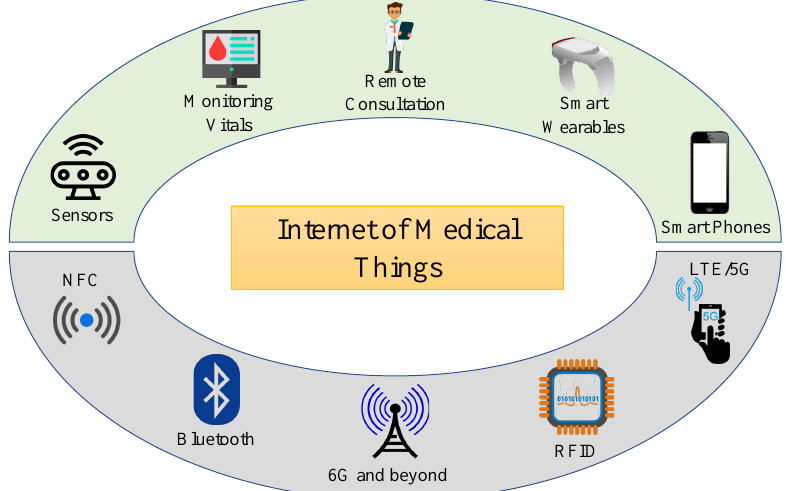
Figure 2. Internet of Medical Things enabling technologies and